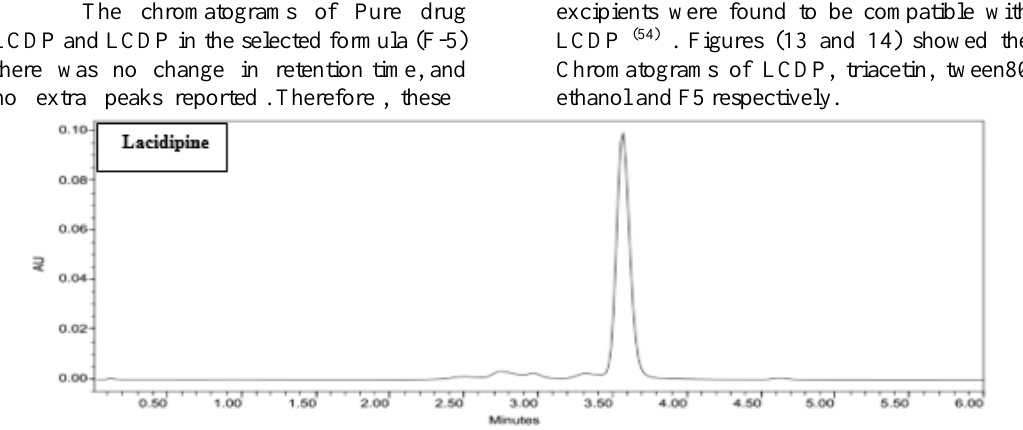
Figure 13. Chromatograms of pure LCDP and triacetin,